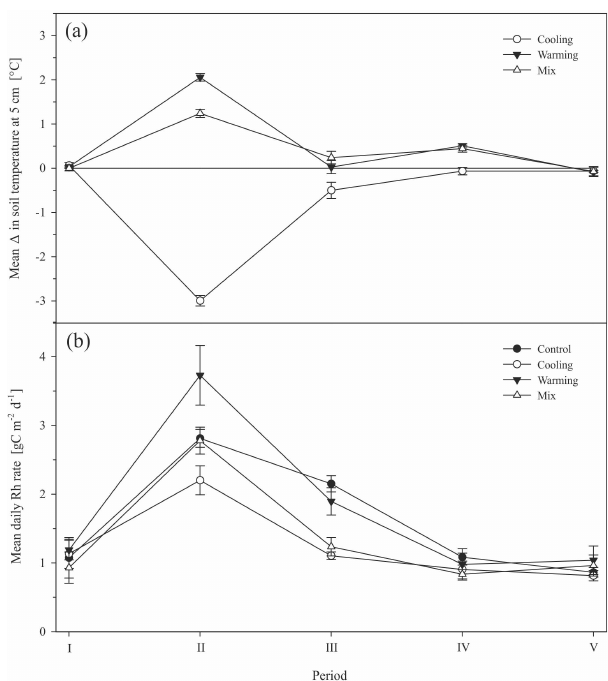
Fig. 1. Mean difference in soil temperature at 5cm depth (treatment − control; a ) and mean daily heterotrophic respiration rates by treatment (b) for each of the study periods considered (I to V). Period I: pretreatment (DOY 60–67); period II: effective treatment period (from treatment application to crop canopy clo- sure, DOY 68–158); period III: after crop canopy closure (from crop canopy closure to harvest, DOY 159–264); period IV: after harvest period (from harvest to ploughing, DOY 265–326); period V: af- ter ploughing (DOY 327–60). Vertical bars represent standard error ( n =